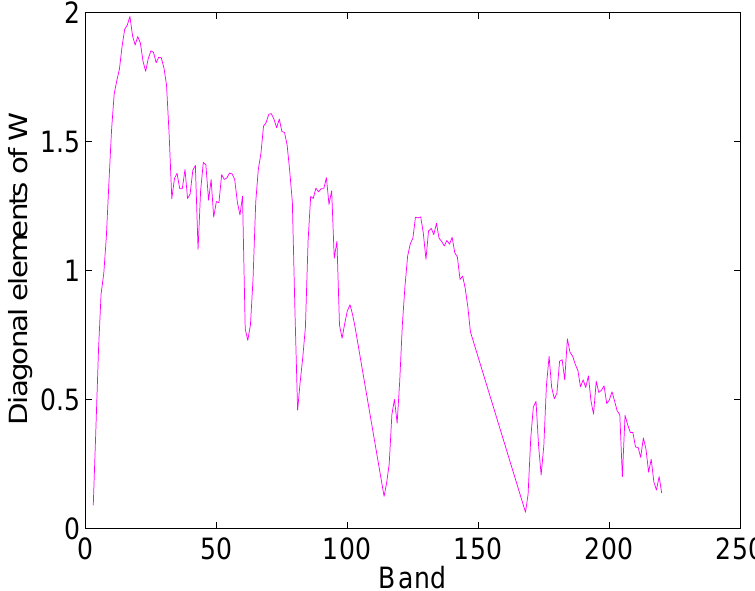
Figure 22. The diagonal elements of weighting matrix for the real